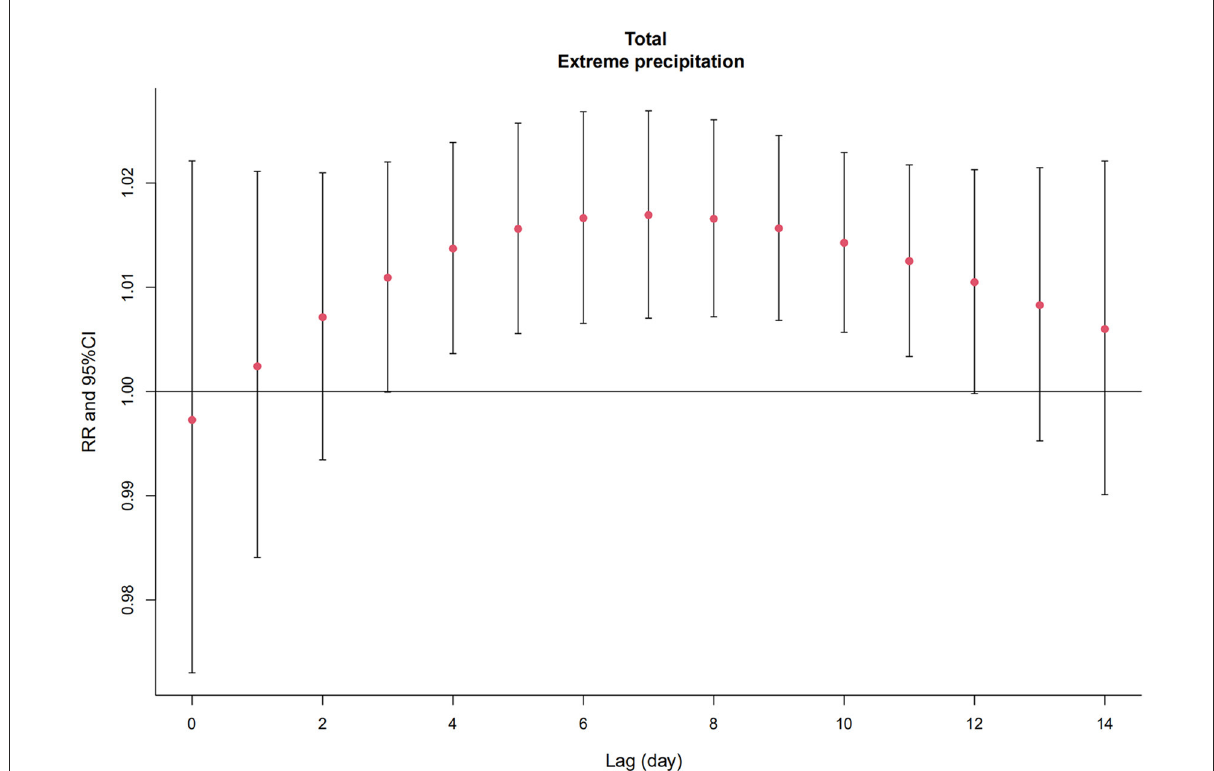
FIGURE3 The relative risk (RR) and 95% confidence interval (CI) of extreme precipitation on total AMI hospitalizations on different lag days in Beijing, China from 2013 to